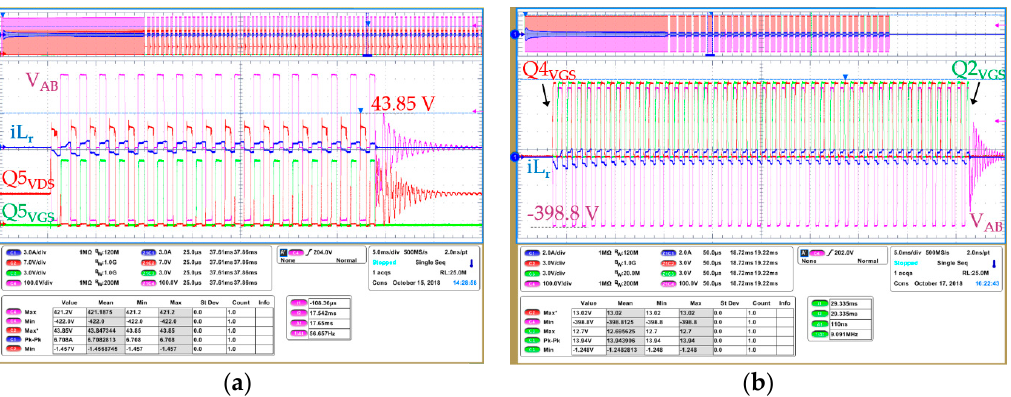
Figure 29. SRs and HV bridge MOSFETs overshoot during burst: ( a ) SRs drain voltage overshoot; ( b ) HV bridge overshoot.